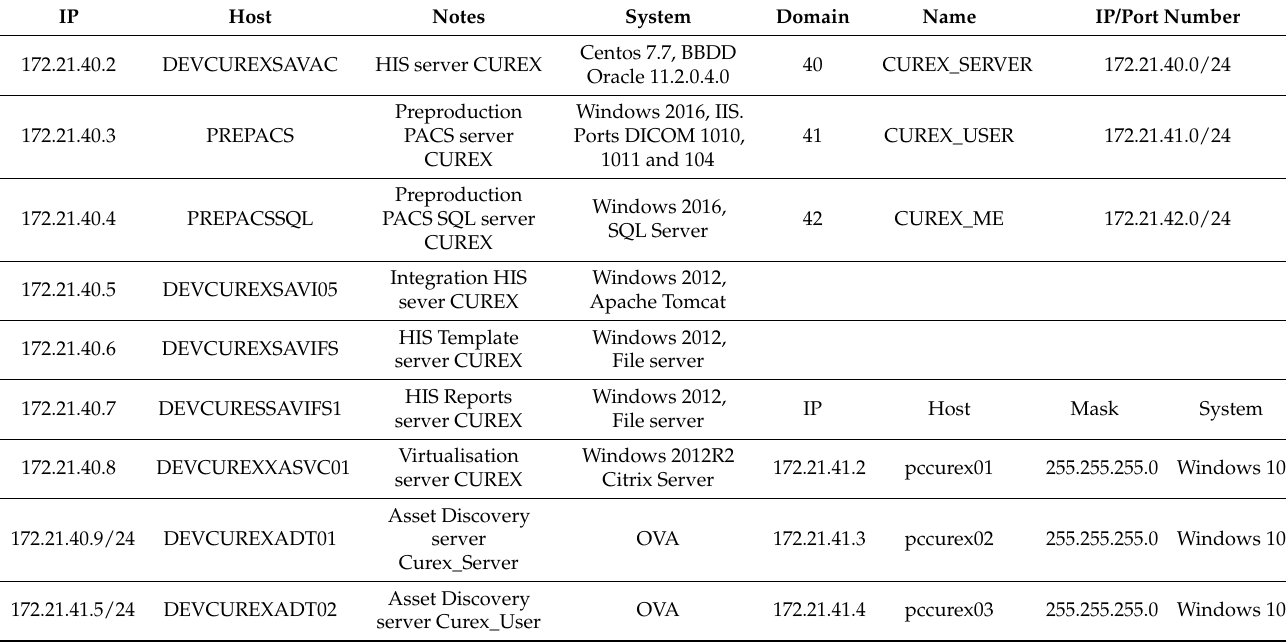
Table 2. Network details of mounted servers in the use case infrastructure, open virtual appliances (OVAs), configured VLANs and virtual